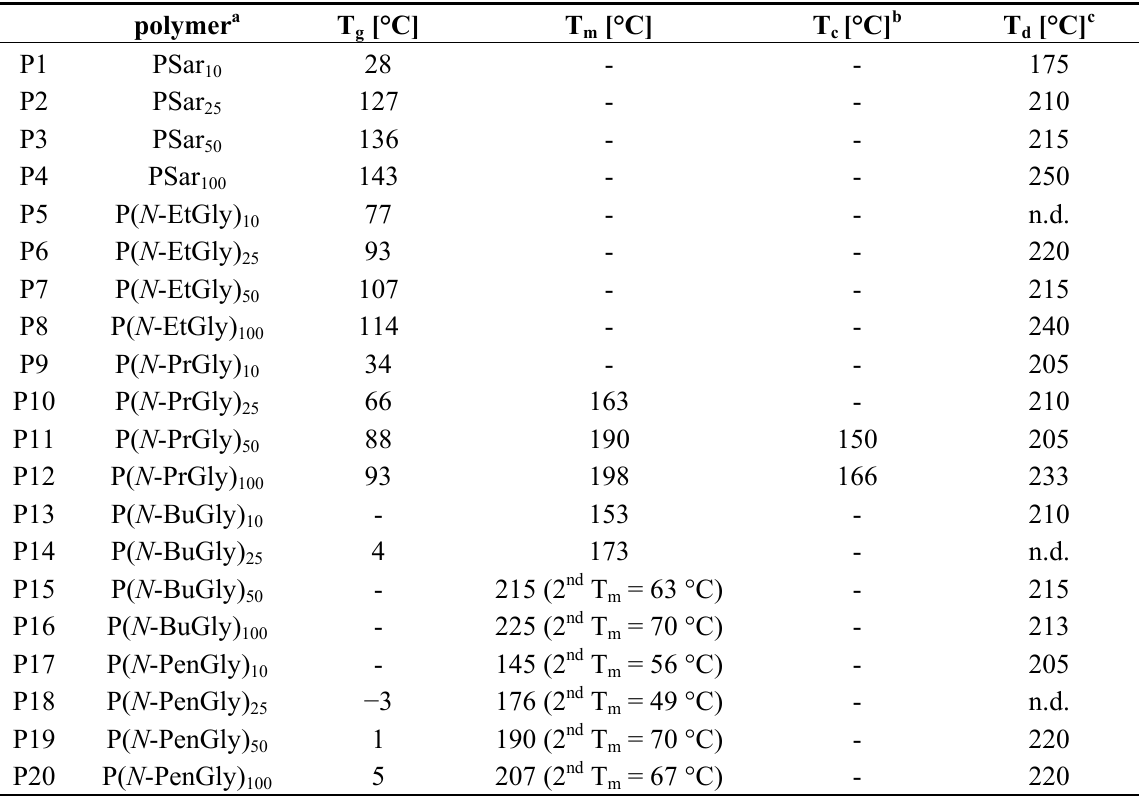
Table 3. Summary of the DSC and TGA